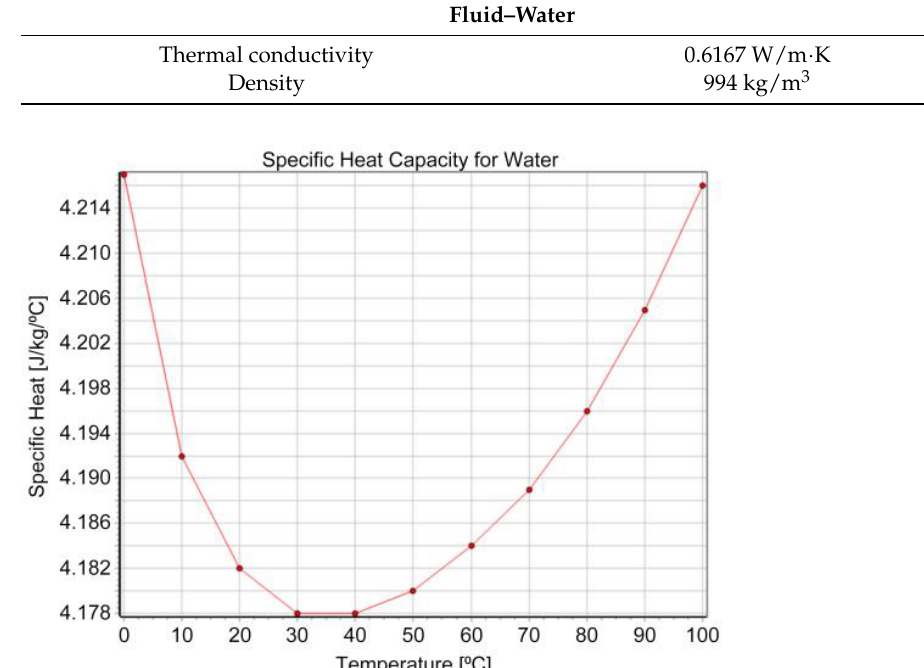
Figure 12. Radial view of water-cooled motor after FEM analysis. Figure 13. Axial view of water-cooled motor (aluminum casing) after the FEM analysis. Table 10 shows the significant reduction in temperatures when using a water-based cooling system in the water-cooled motor with aluminum (Alloy 195 cast) casing. The highest temperature observed here was 124 °C, which is 50.4% lower than the highest temperature observed in the thermal analysis of the fan-cooled motor (250 °C).